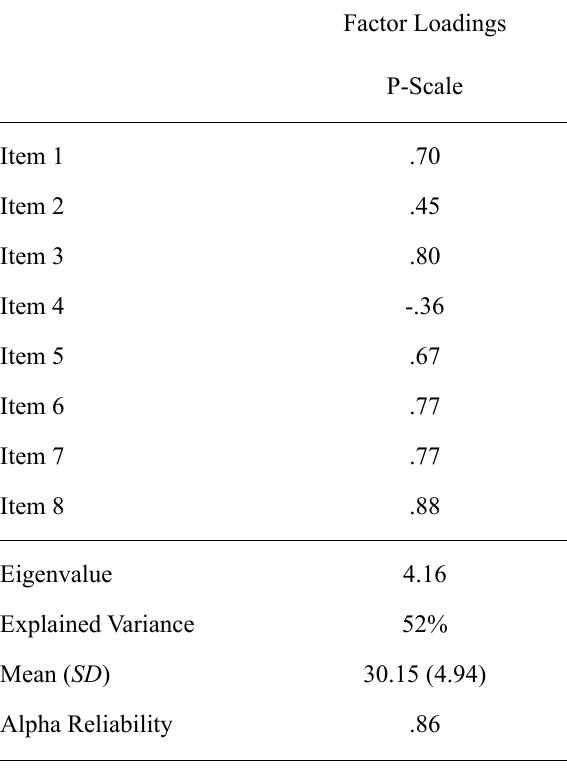
Exploratory Factor Analysis of the Brazilian Version of the Positivity Scale (P-Scale)